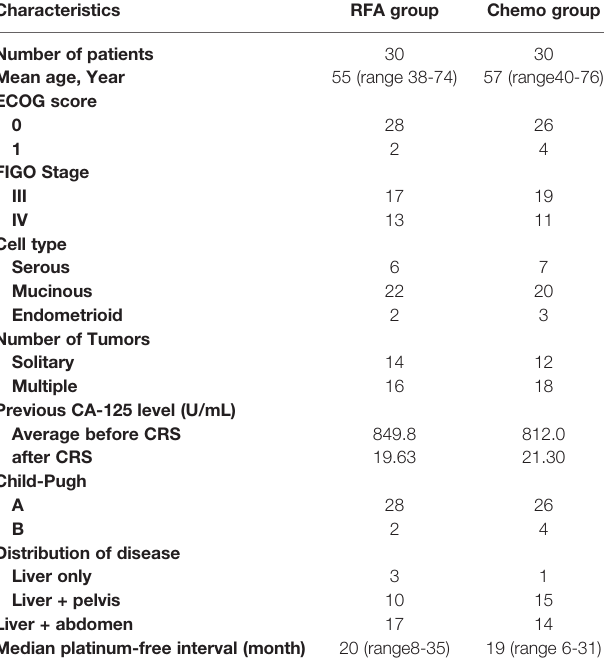
TABLE 2 | Characteristics of